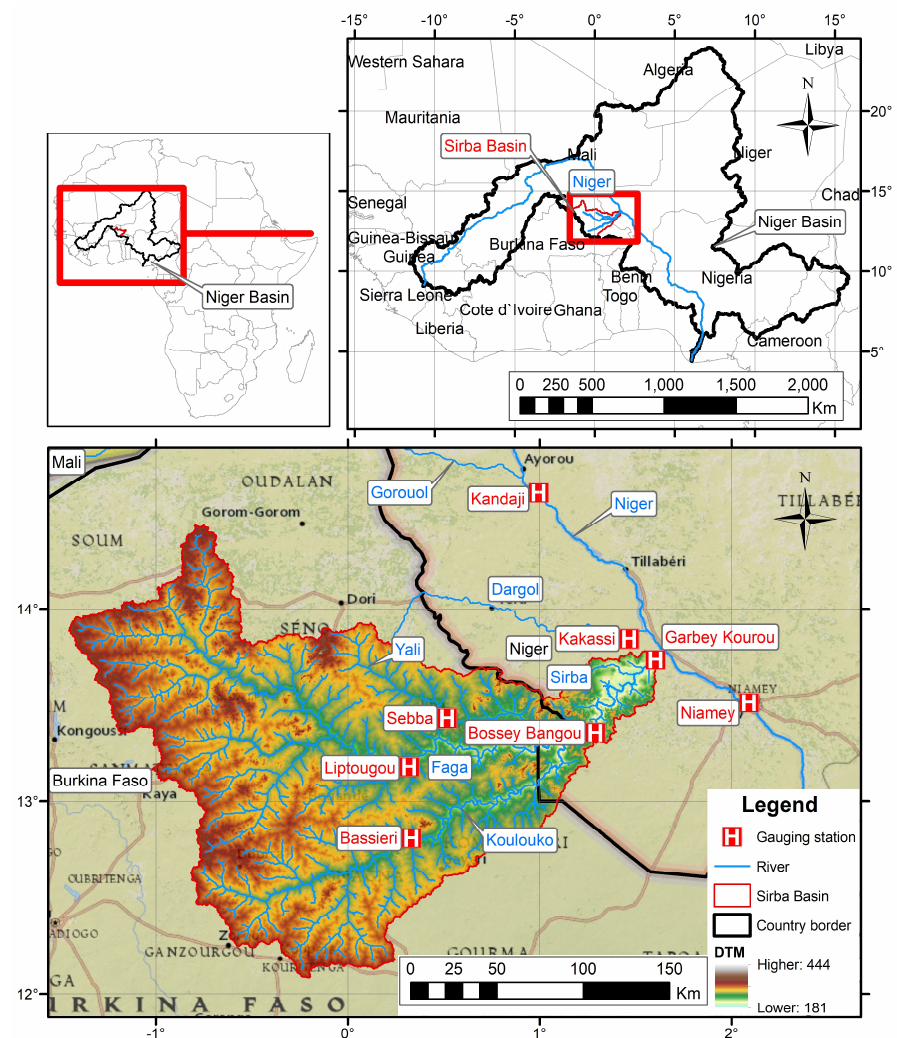
Figure 1. Geographical location of the Niger and Sirba River catchments. Enlargement: Sirba River hydrography, topography, and the location of the discharge gauging stations indicated in Table 2.